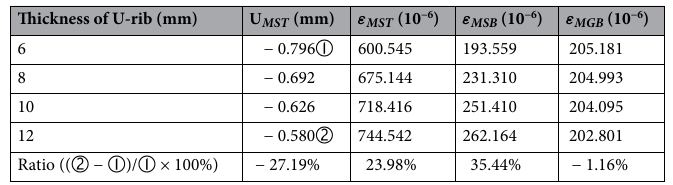
Table 6. Critical responses with the different thickness of U-rib at the high temperature.